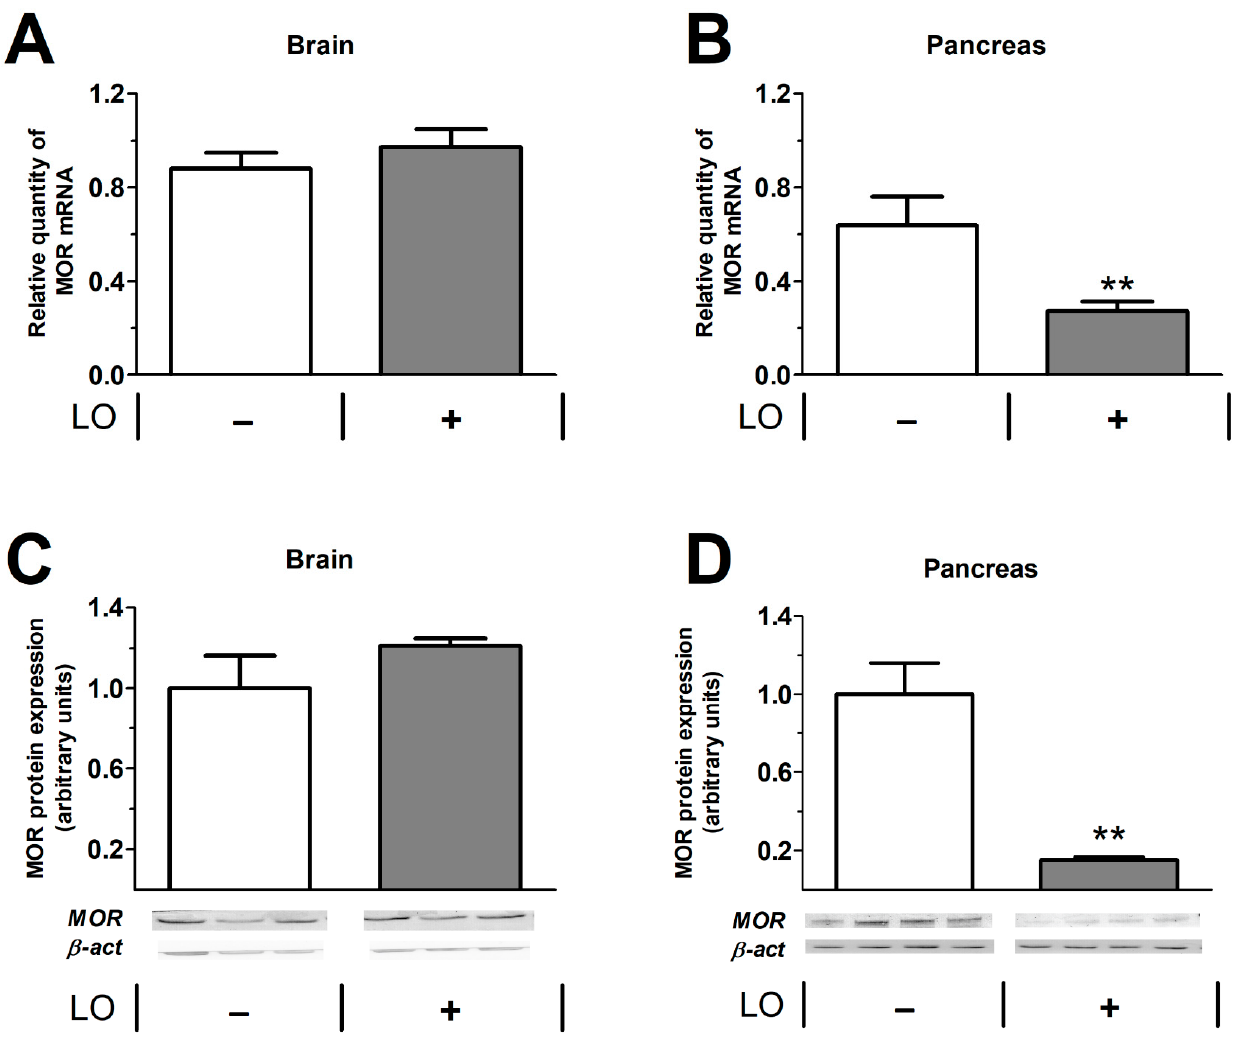
Figure 10. Expression of mu opioid receptor (MOR) in the brain and pancreas in control and LO- induced AP. Rats were treated with vehicle or 3 g/kg LO-HCl and were sacrificed at 24 h. MOR mRNA ( A , B ) and protein ( C , D ) expression levels were determined in the brain ( A , C ) and pancreas ( B , D ). In ( C , D ), the bar charts show the quantitative analysis of Western blot images. Values represent mean with standard error, n = 13–17 (RT-PCR), n = 3–4 (Western blot analysis). Student’s t test was performed, ** p < 0.01. Abbreviations: LO, L-ornithine-induced acute pancreatitis; β -act, β -actin; MOR, mu opioid receptor.